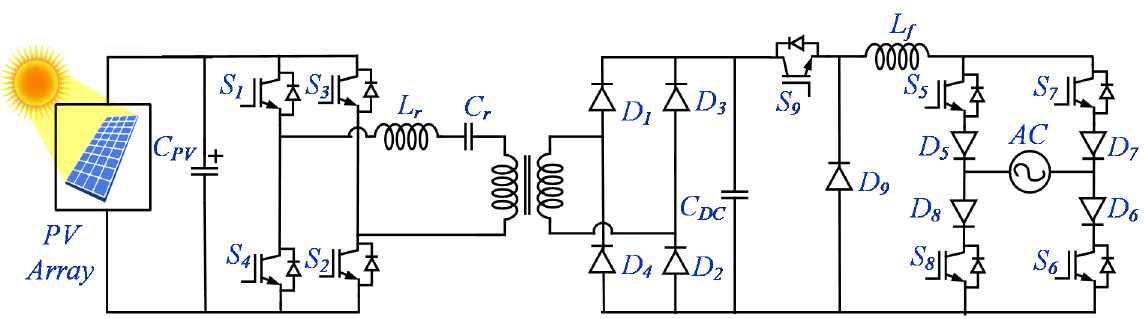
Figure 30. Three stage fly-back inverter with soft switching.